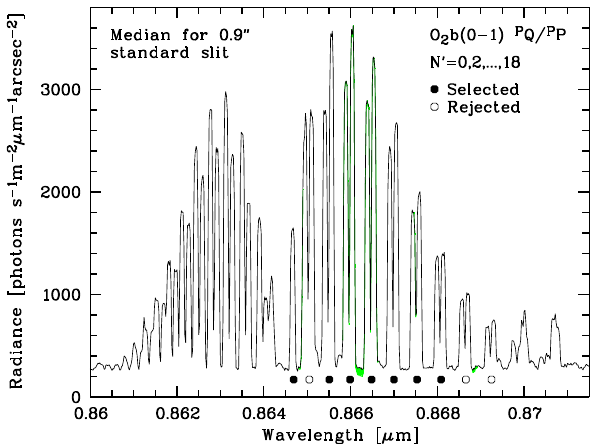
Figure 3. Median X-shooter spectrum of O 2 b (0-1) for the 189 VIS- arm sample spectra taken with the standard slit width of 0.9 (cid:48)(cid:48) . The original spectrum was corrected for solar absorption lines in the continuum (green areas). Pairs of P Q and P P lines with even upper rotational levels N (cid:48) from 0 to 18 are marked by circles. Note that P Q (0) does not exist. The filled symbols indicate lines that were used for the derivation of T rot